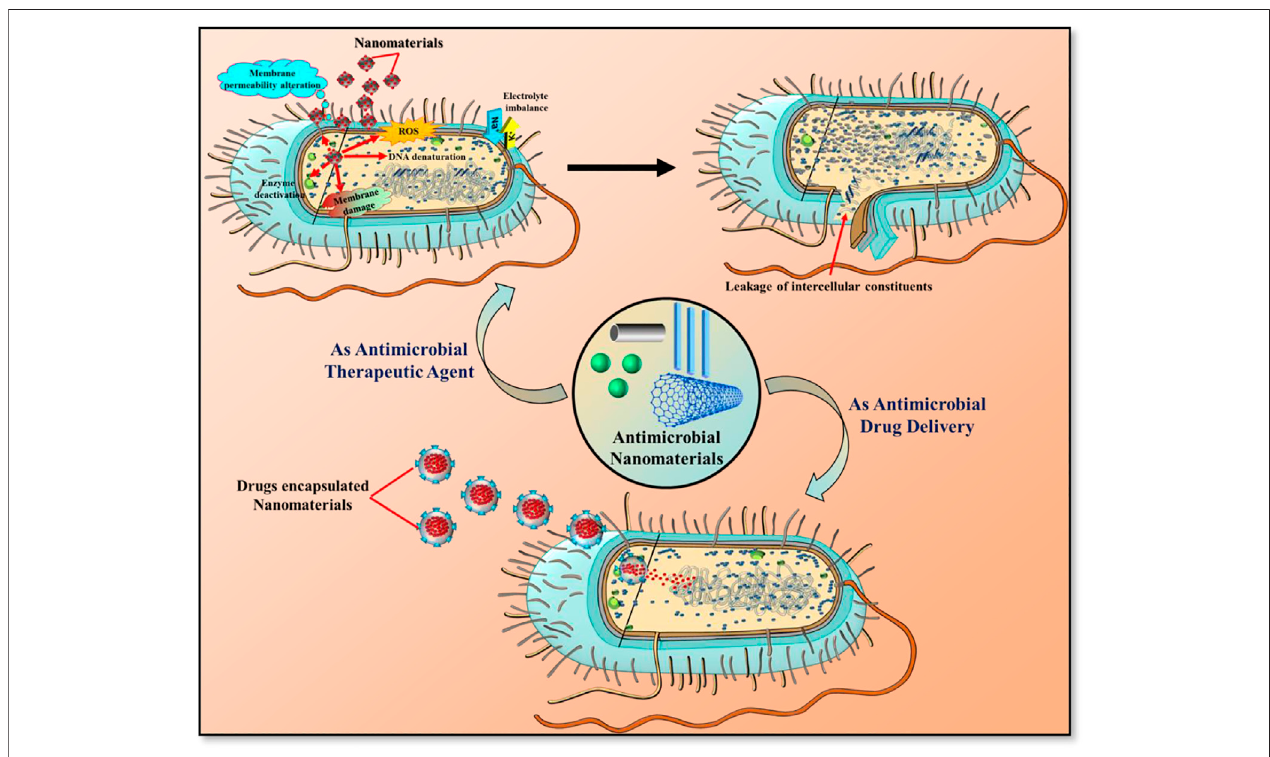
FIGURE 1 | Potential applications of antimicrobial nanomaterials as therapeutic agent and drug delivery carrier.